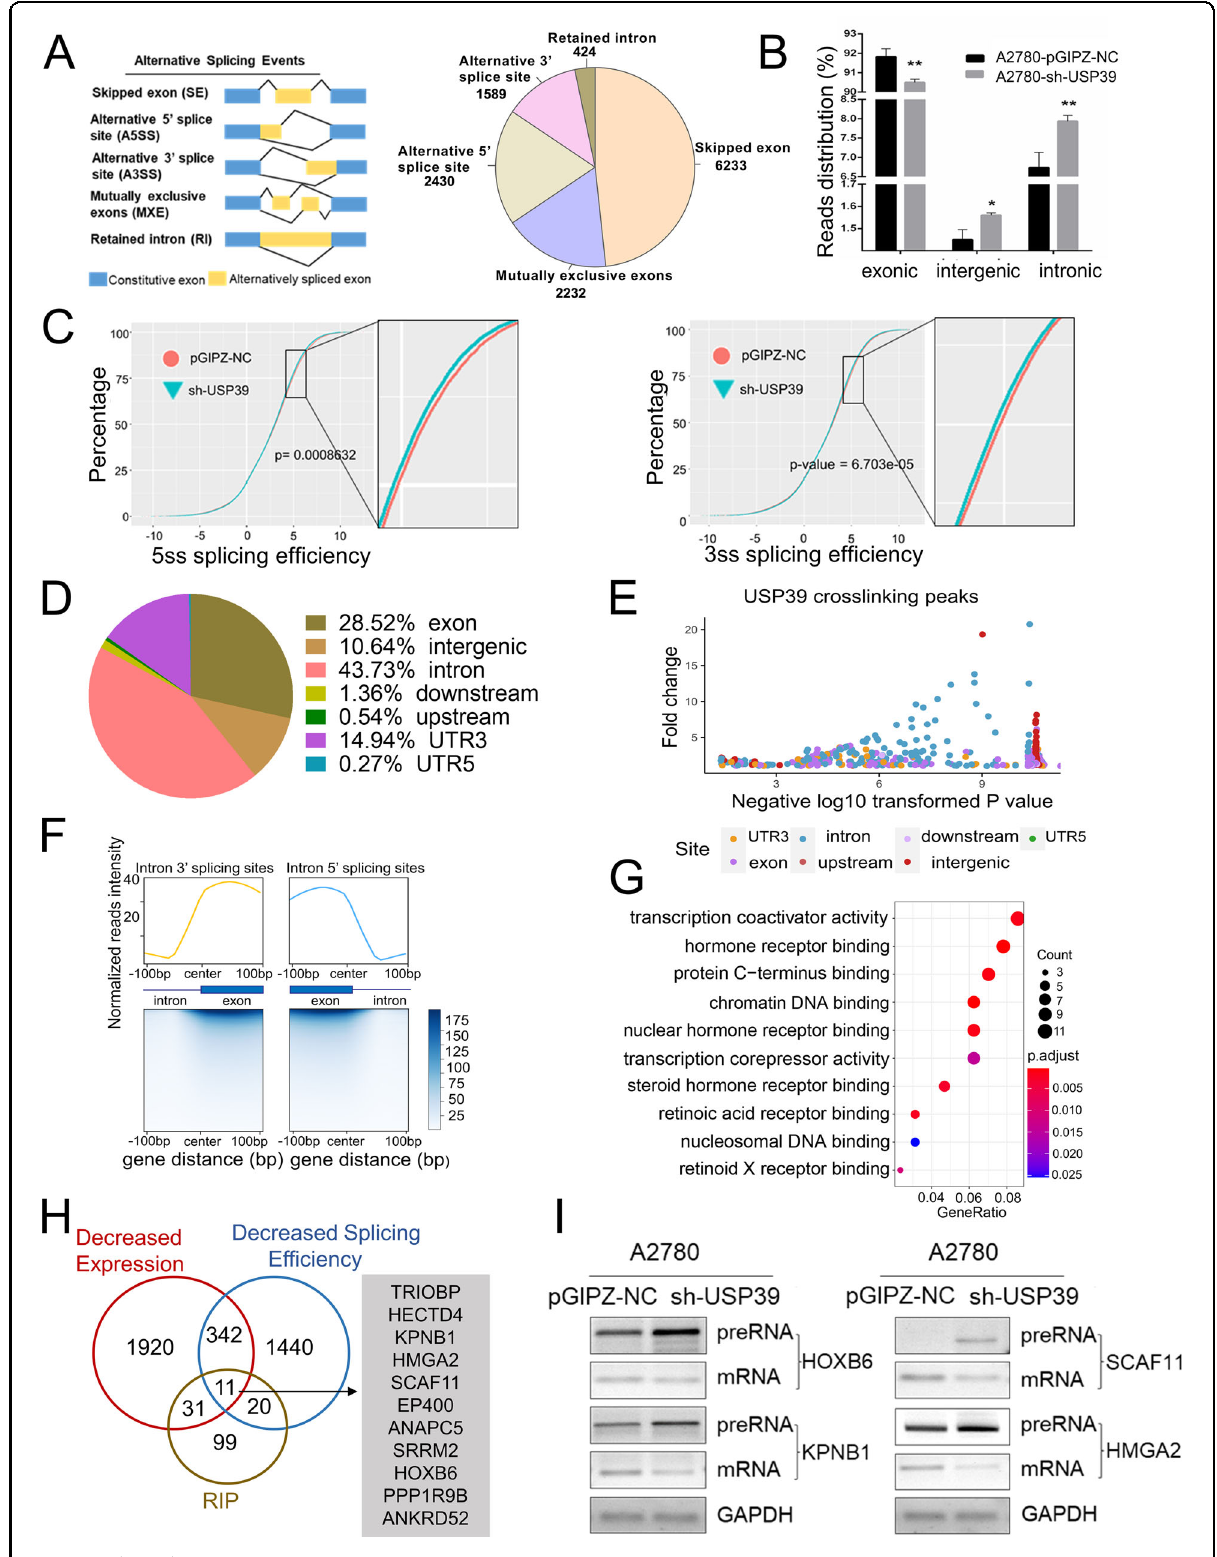
Fig. 6 (See legend on next